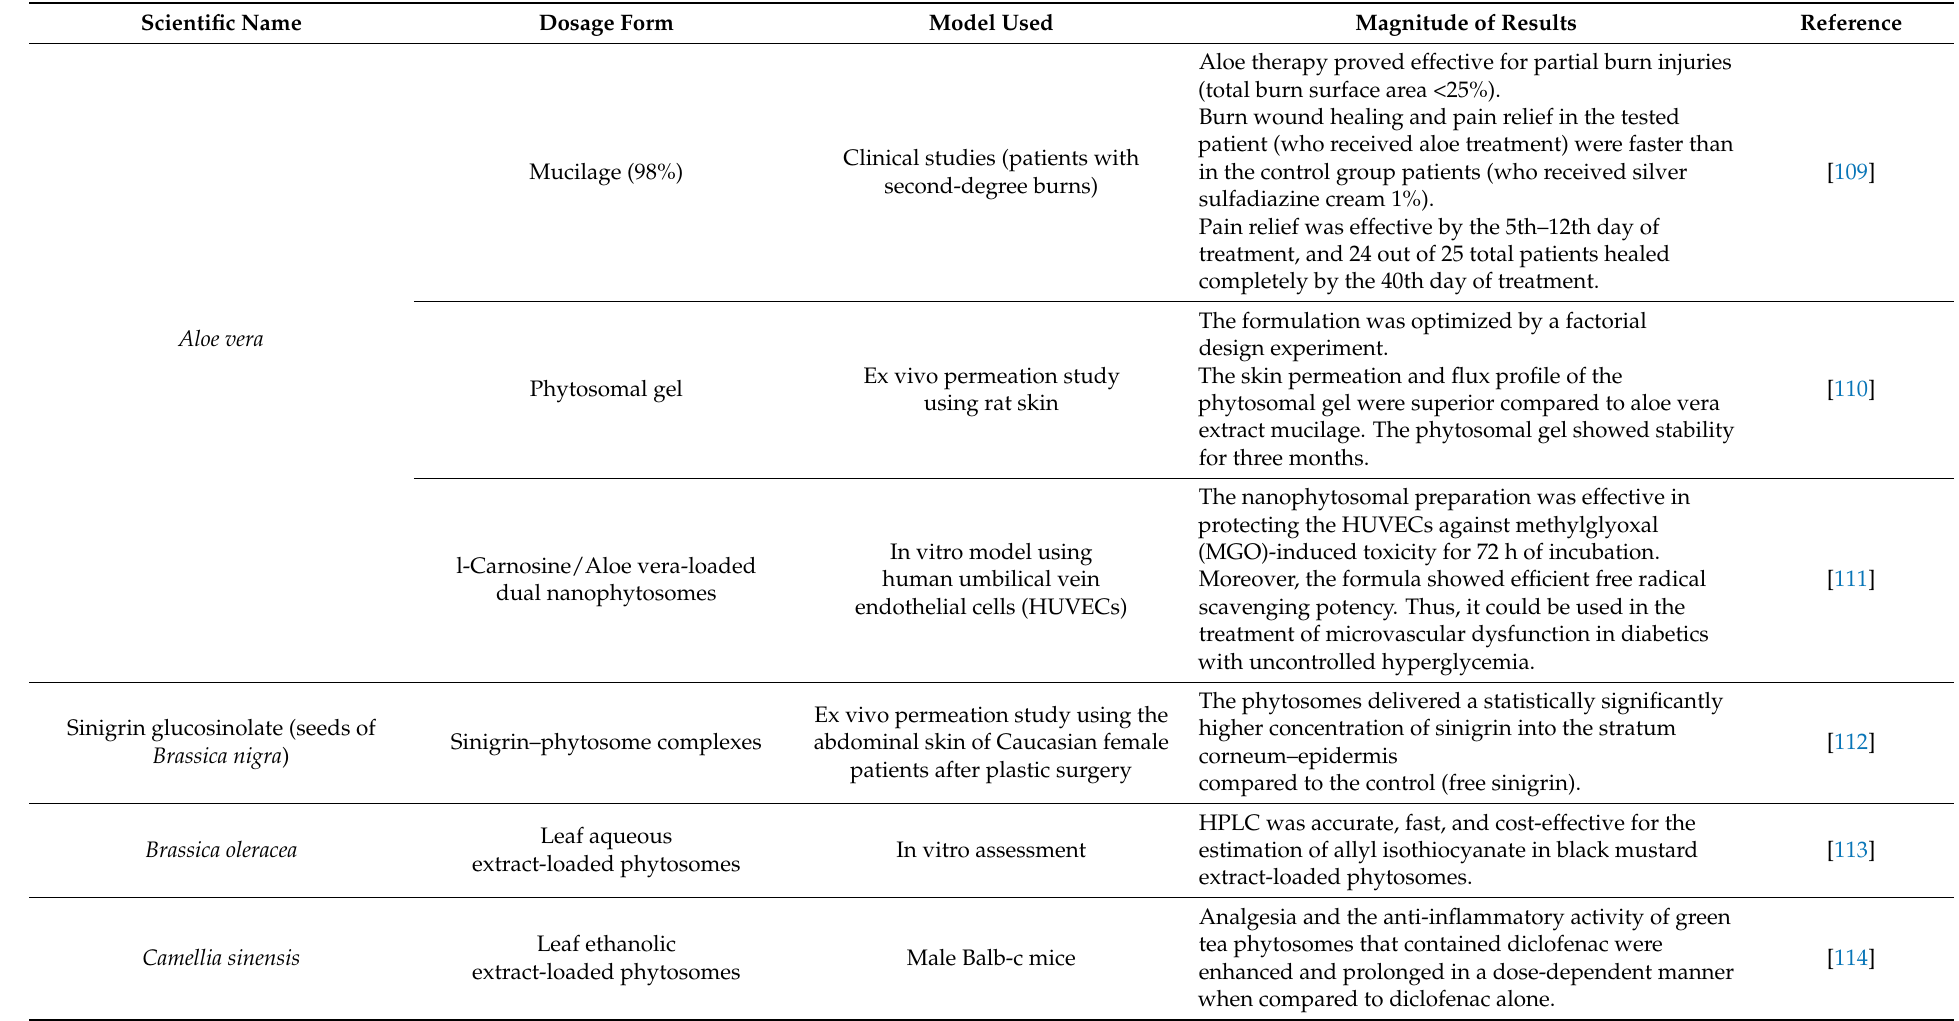
Table 8. Phytosome-based herbal formulations for burn/wound